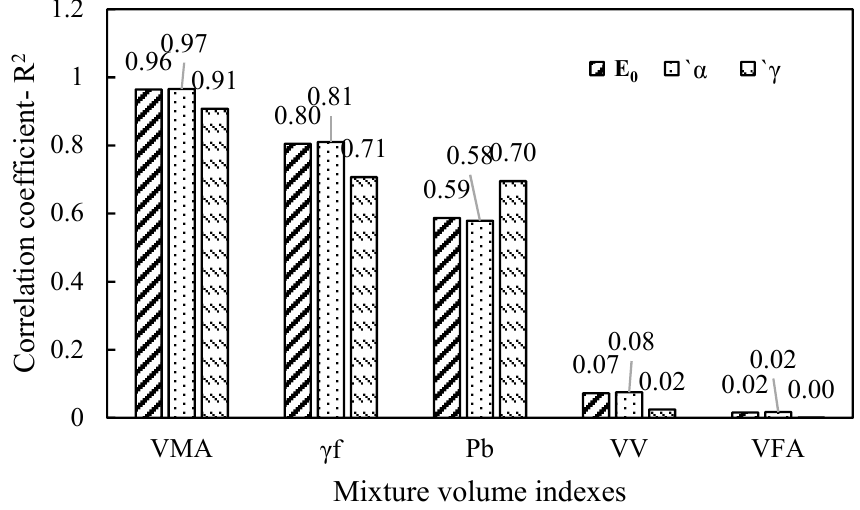
Figure 3. Correlation between the modulus master curve parameters and mixture volume indexes.